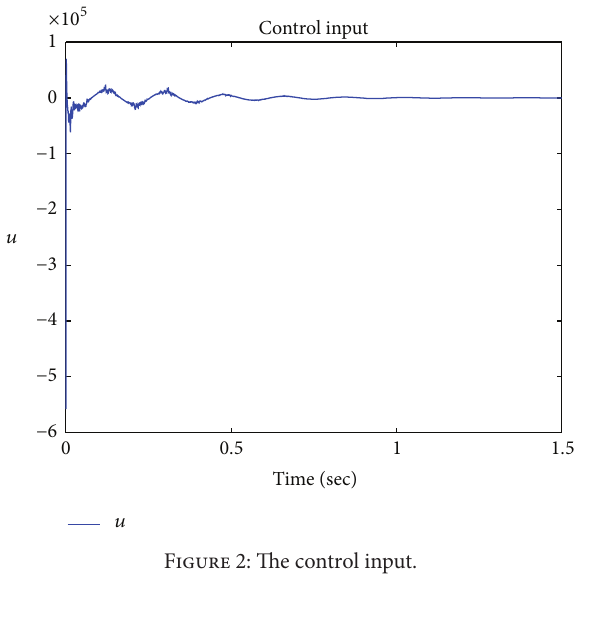
Figure 2: The control